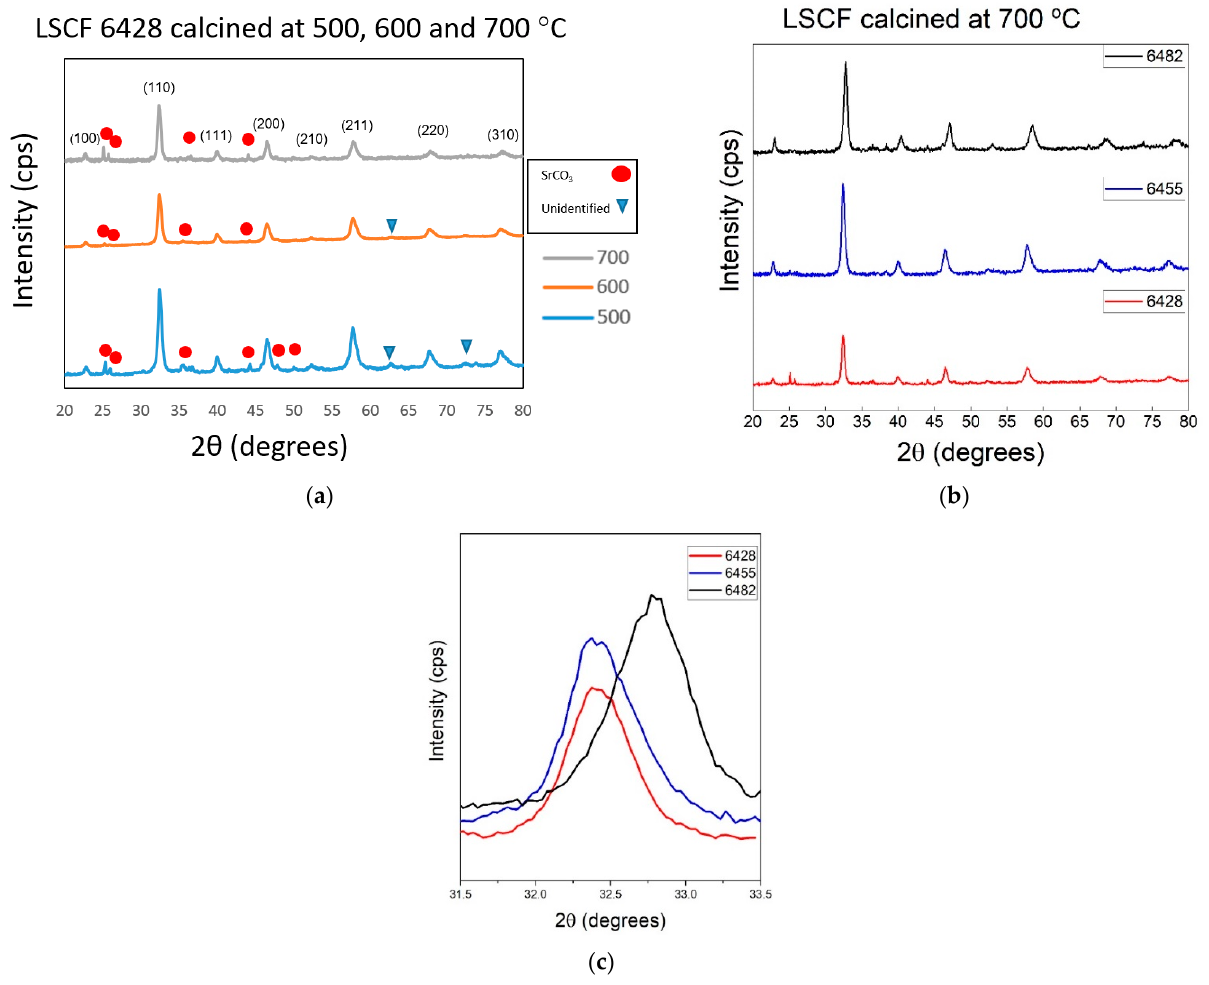
Figure 3. ( a ) XRD of calcined powders of LSCF 6428 at 500, 600, and 700 °C for 2 h; ( b ) comparison of XRD pattern of different compositions of LSCF calcined at 700 °C for 2 h; ( c ) comparison of (110) peak position of LSCF 6428, 6455, and 6482 calcined at 700 °C for 2 h.